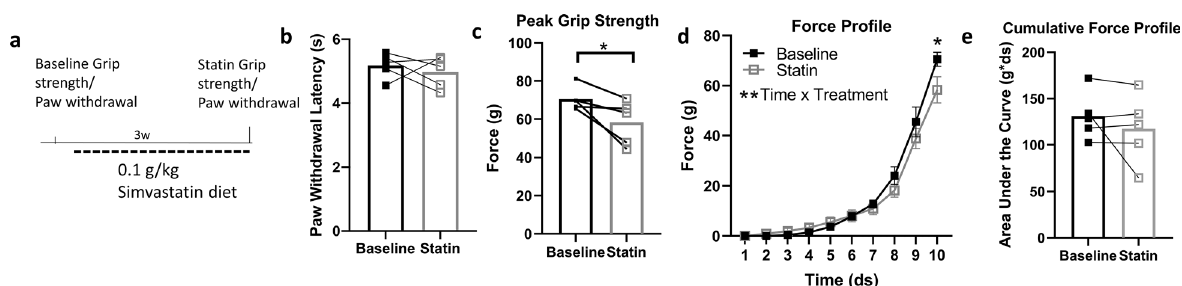
Figure 3. Acute statin treatment impairs grip strength and force profile, but not cumulative force profile. ( a ) Experimental design for assessing statin-associated muscle symptoms in female C57BL/6 J mice. ( b ) Statin treatment does not affect mechanical sensitivity, as determined by automated paw withdrawal thresholds. ( c , d ) Statin-treated mice have reduced grip strength and force profile (*p < 0.05, paired t-test, Tukey’s multiple comparison; **p < 0.01 time × treatment interaction, two-way repeated measures ANOVA; n = 5/group). ( e ) Statin treatment does not alter cumulative force the kinetics were slightly different between sexes. Males rapidly gained weight and plateaued, whereas females lagged behind in the first weeks, but ultimately reached a similar proportional weight gain as males (Fig. 4c). After 11 weeks of HFD, the proportional fat and lean mass was similar for males and females (Fig. 4d,e). Consistent with expected effects of chronic HFD feeding, males and females exhibited impaired glucose toler- ance compared to their baseline levels on chow diet (Fig. 4f,g). In addition, both male and female mice exhibited elevations in fasting glucose levels on HFD compared to their baseline values (Fig. 4h). Males had higher absolute levels of glucose intolerance and fasting glucose than female mice (Fig. 4f–h), consistent with previous reports in young male vs. female C57BL/6J mice fed HFD 40 . We measured grip strength parameters at baseline and after 6 weeks of HFD. At 6 weeks of HFD, we identi- fied an effect of sex on grip strength and cumulative force profile, with females showing lower values for both parameters compared to their male counterparts (Fig. 5a,c). However, these differences were at least partially accounted for by body weight, as normalization to body weight revealed similar reductions to grip strength in females and males, and similar cumulative force profiles between the sexes (Fig. 5d,f). Force profile was altered